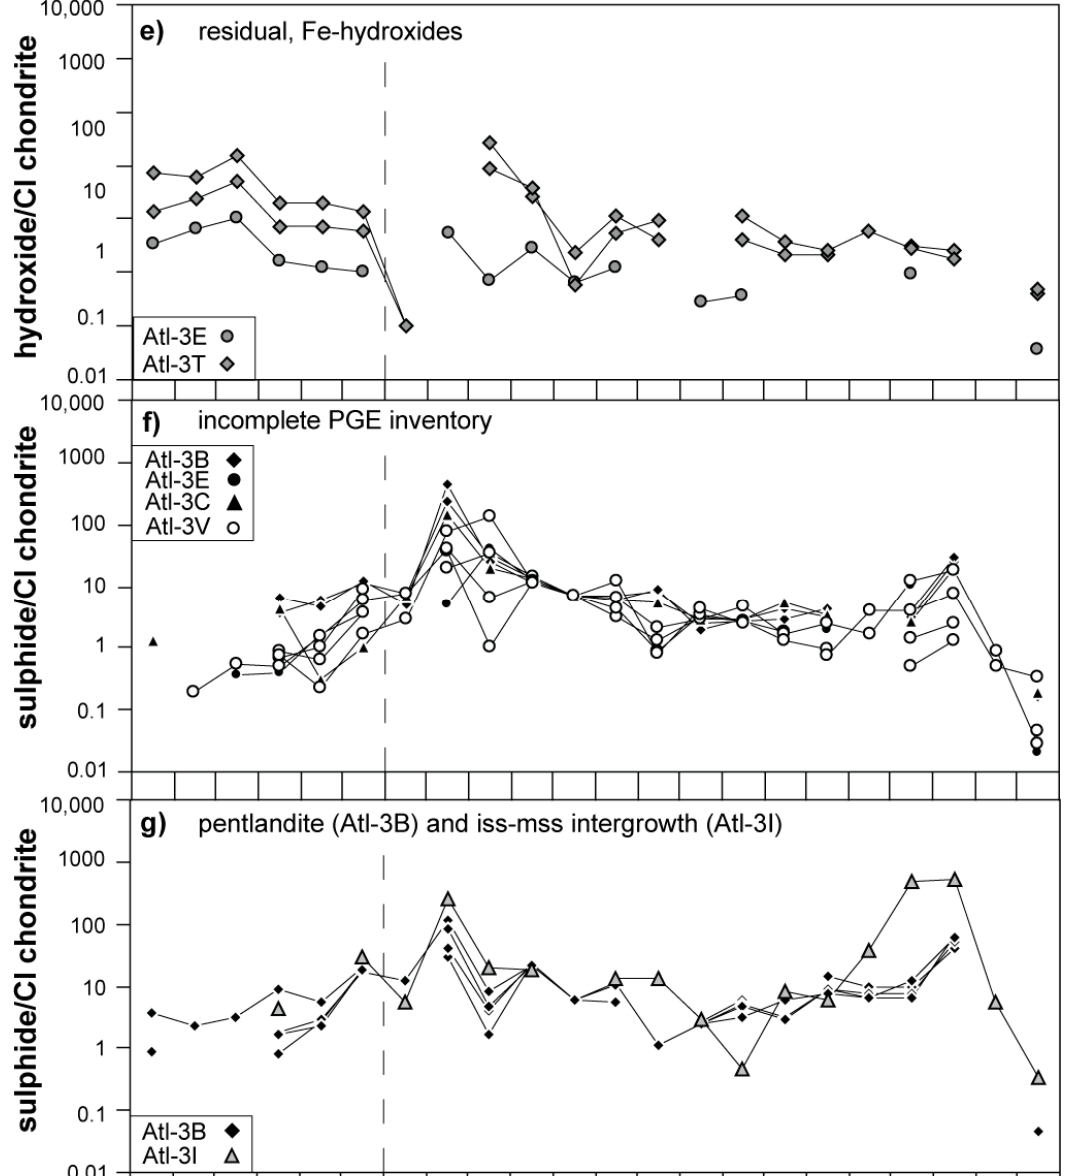
Figure 6. Chondrite-normalized [40] siderophile/chalcophile element systematics determined in residual mss, Panels ( a ) and ( b ); secondary mss, Panels ( c ) and ( d ); mss with an incomplete PGE inventory ( f ), Fe-hydroxides ( e ), and pentlandites and the mss–iss intergrowth ( g ). The dashed line separates PGE systematics from those of the other (trace) elements. Host xenoliths are indicated by symbols.